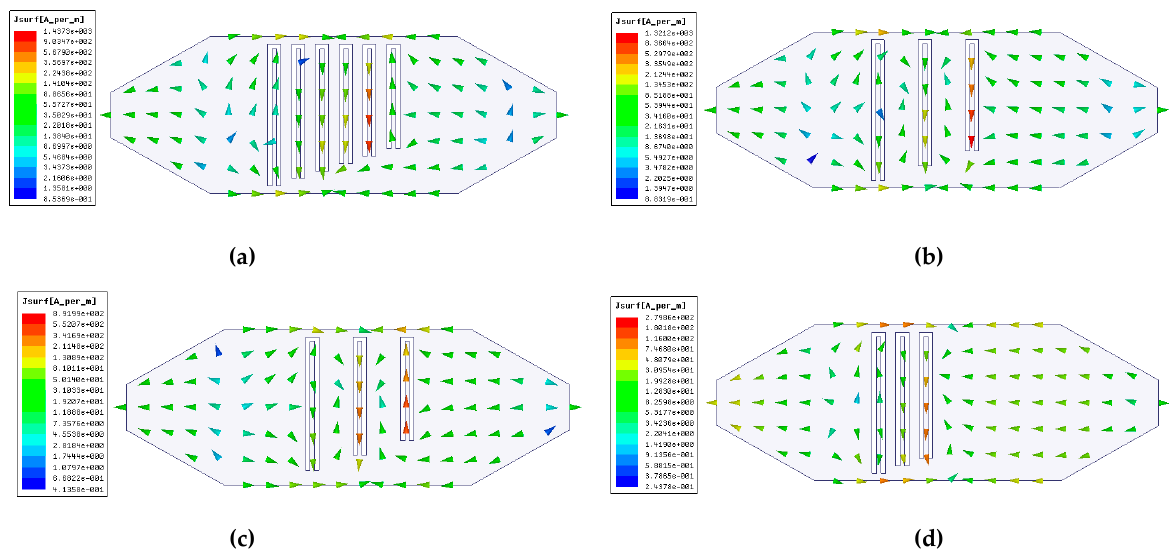
Figure 11. Current vector diagram of U-shaped slot resonator: ( a ) ID111111; ( b ) ID101010; ( c ) ID010101; ( d ) Figure 9: Current vector diagram of U-shaped slot resonator: (a)ID111111; (b)ID101010; (c) ID010101; (d) ID111000.